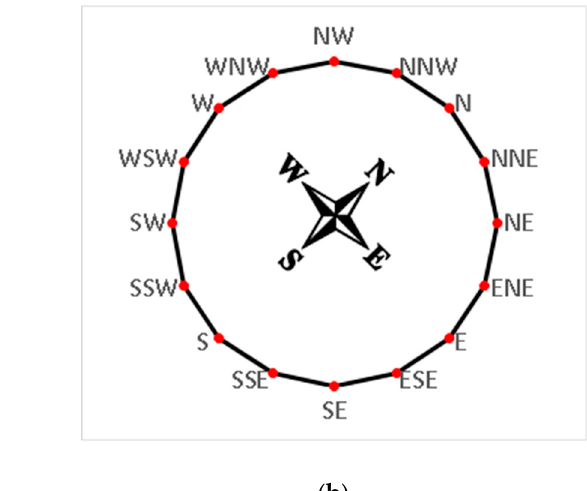
Figure 11. Circular urban area model (red area—the focus urban area) with surroundings at a scale of 1/100 with a radius of 200 m from the midway point.